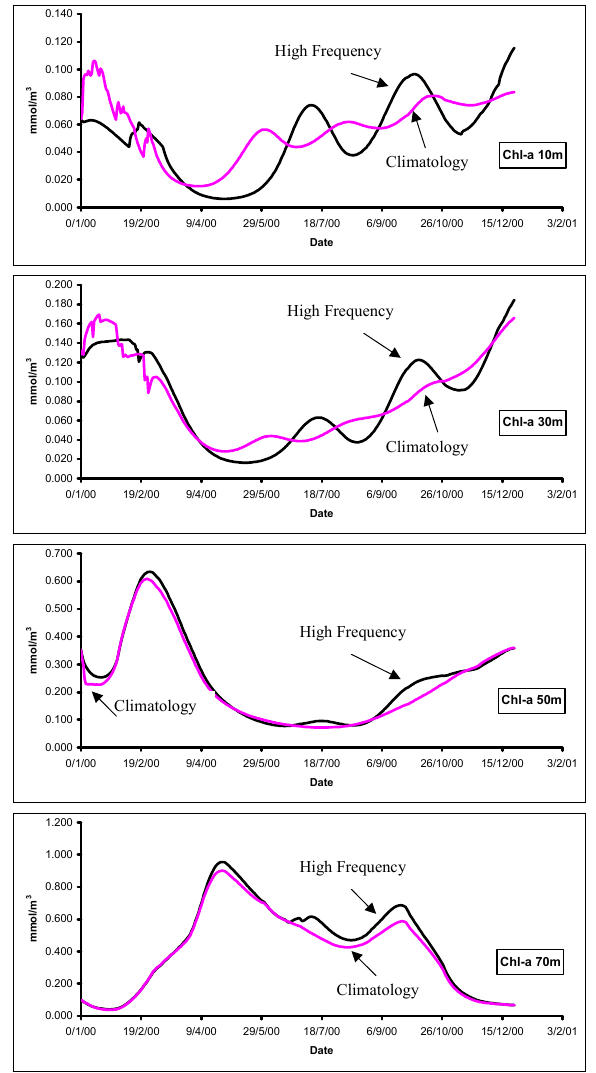
Fig. 8. Model chlorophyll simulations at various depths with clima- tological and real-time